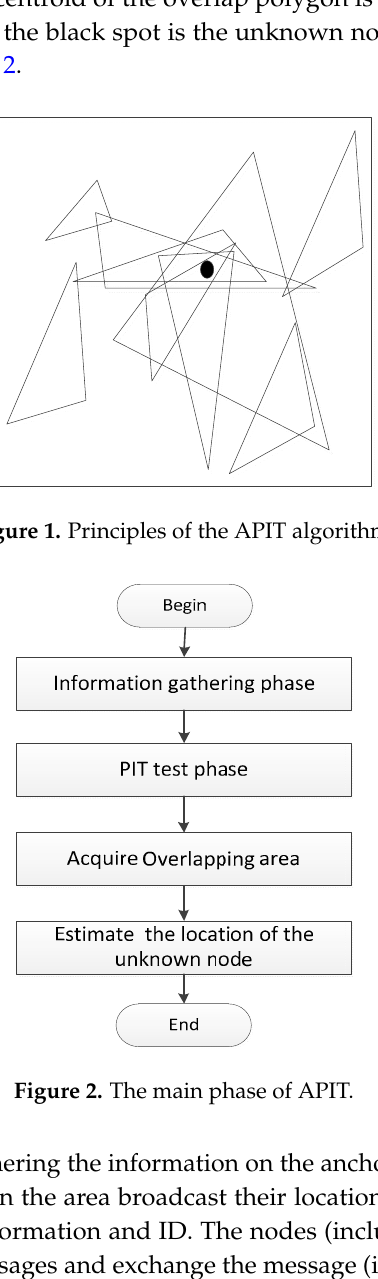
Figure 3. Format of the message broadcasted by anchor nodes.